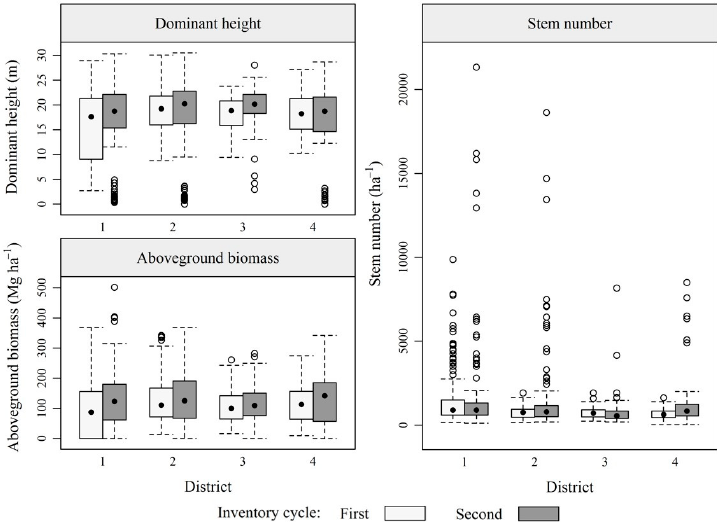
Figure 2. Box plots showing the distribution of computed field plot data.